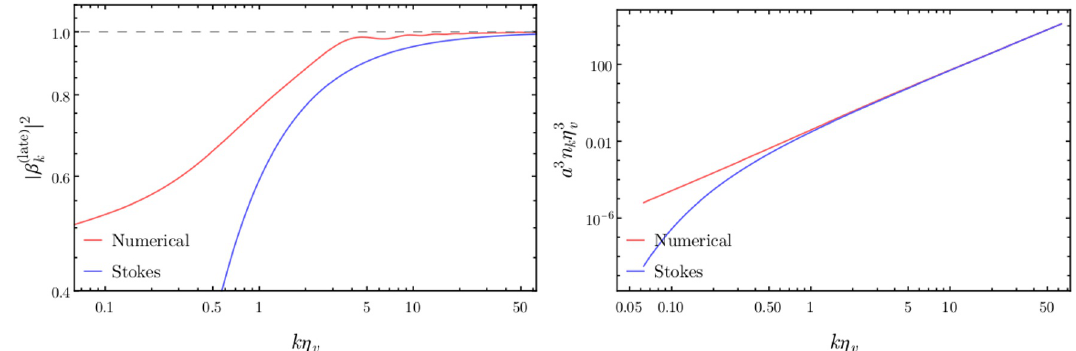
Figure 8 . A comparison of the particle production obtained by solving the mode equations numerically (red curve) and by evaluating the Stokes phenomenon (blue curve). The horizontal axis is comoving wavenumber k in units of η − 1 . The left panel shows the squared Bogoliubov v coefficent | β (late) | 2 , and the right panel shows the comoving number density (per d.o.f) a 3 n k ∝ k k 3 | β (late) | 2 in units of η − 3 . The numerical and analytical calculations agree well at high k where v k they exhibit | β (late) | 2 ≈ 1 , confirming the phenomenon of ‘catastrophic’ particle production observed k in earlier